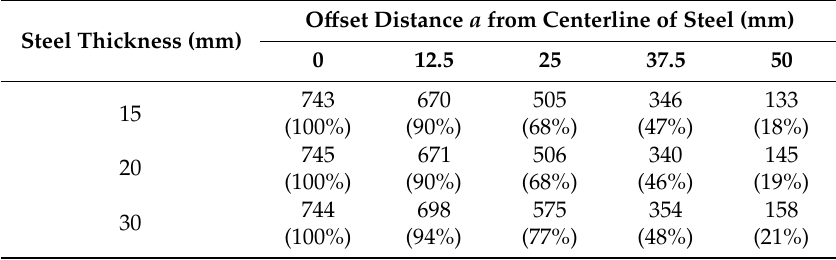
V  (m/s) for depth variation at t = 20 mm and h = 150 mm.